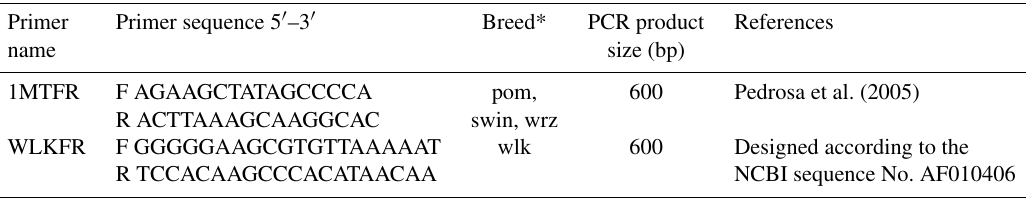
Table 1. Primers used for the amplification and sequencing of the D-loop of Polish sheep. Primer Primer sequence 5 (cid:48) –3 (cid:48) Breed* PCR